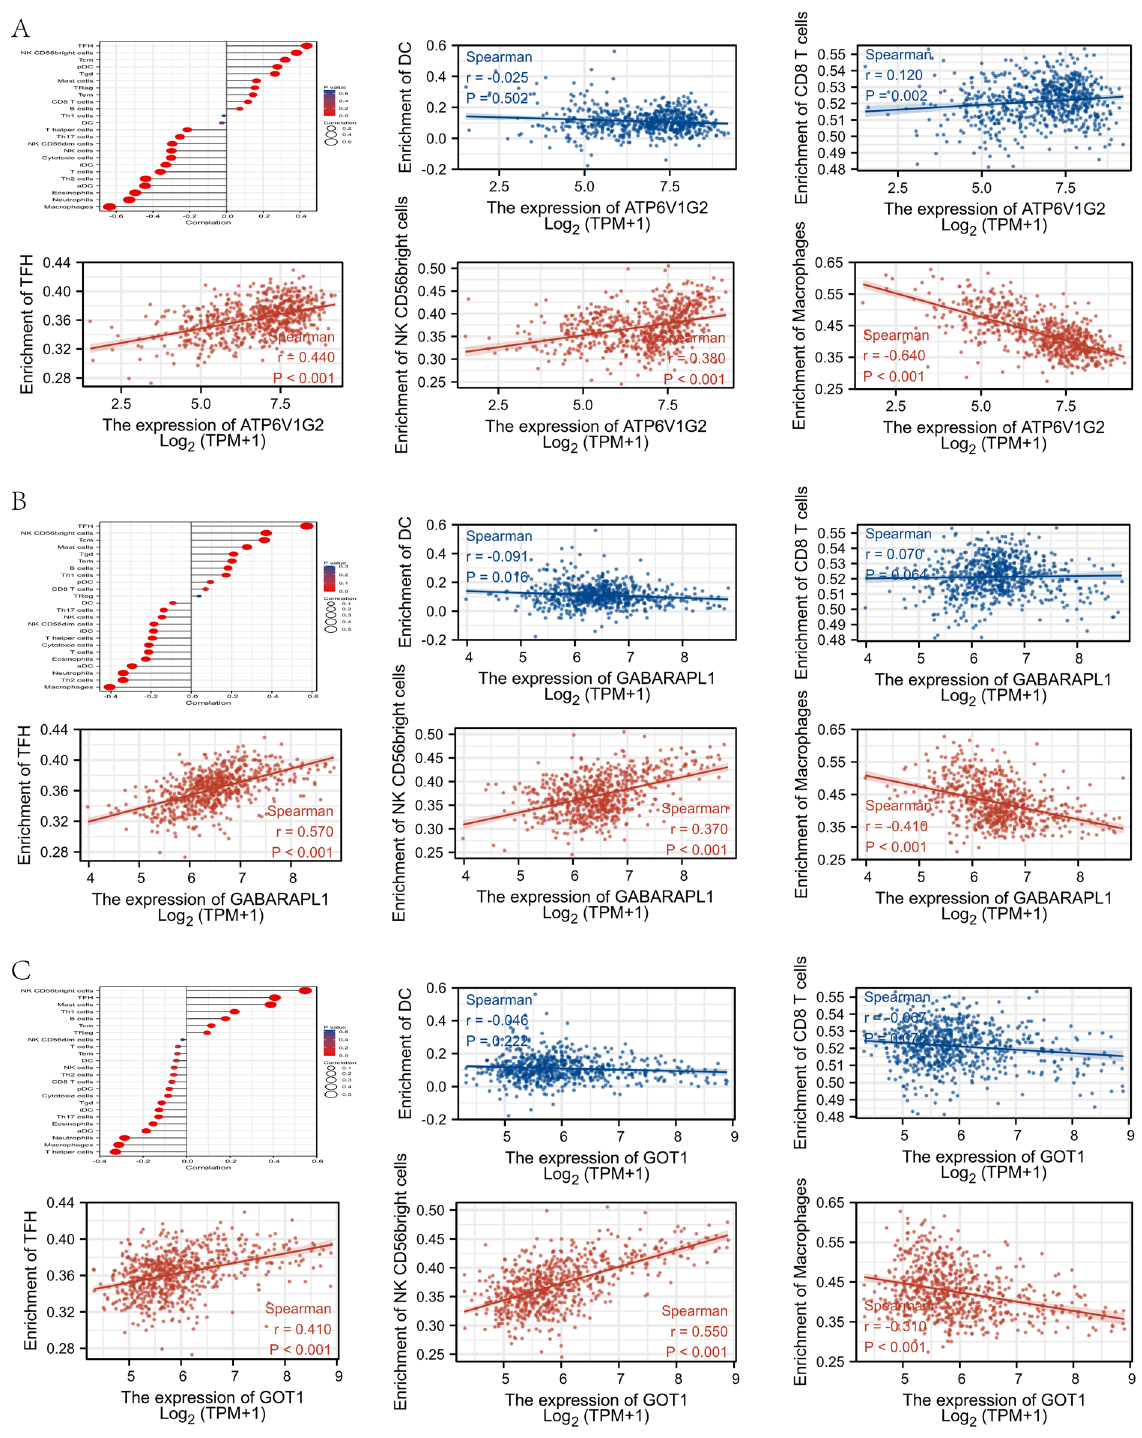
Figure 5. Visualization of the immune infiltration analysis in TCGA database. Association of ATP6V1G2 expression ( A ), GABARAPL1 expression ( B ), GOT1 expression ( C ) with immune cells infiltration,